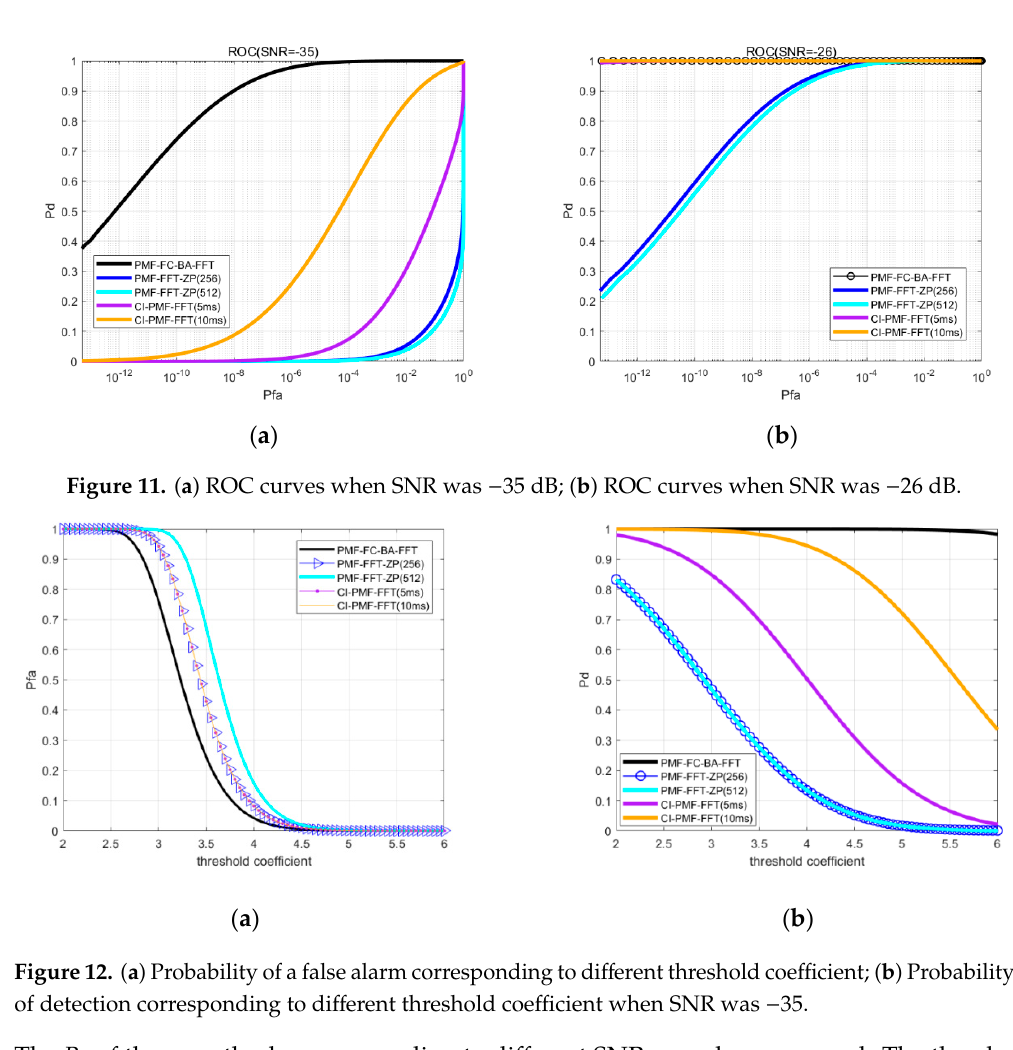
( d ) Figure 10. ( a ) CDF of PMF-FC-BA-FFT and PMF-FFT-ZP when SNR was − 20 dB; ( b ) CDF of PMF-FC- BA-FFT and CI-PMF-FFT when SNR was − 20 dB; ( c ) CDF of PMF-FC-BA-FFT and PMF-FFT-ZP when SNR was − 26 dB; ( d ) CDF of PMF-FC-BA-FFT and CI-PMF-FFT when SNR was − 26 dB. 4.4. Acquisition Sensitivity 𝑃 (cid:3031) , 𝑃 (cid:3033)(cid:3028) and ROC curves were used to evaluate the performance of acquisition under weak signal environments. Figure 11a,b is the ROC curve of these five methods under different SNR environments. Better performance means the high probability of detection and the low probability of false alarm. The area under the curve (AUC) can effectively and intuitively represent the performance of the acquisition method. It is clear that the AUC of the proposed method was higher than other methods so the PMF-FC-BA-FFT acquisition method performed better under a weak signal